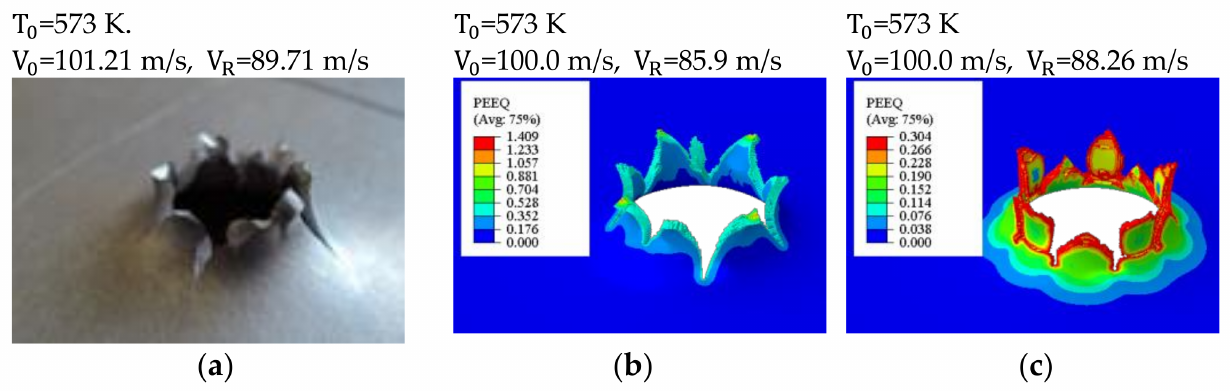
Figure 8. Petalling observed during the numerical simulation: V 0 = 100 m/s, T 0 = 573 K; the sequence of pictures: ( a ) experiment, ( b ) simulation using the Johnson–Cook failure criterion (our own data), ( c ) simulation using a constant initiation damage parameter. Figure 9 recapitulates numerical results for different failure criteria which are com- pared to the curves determined from the